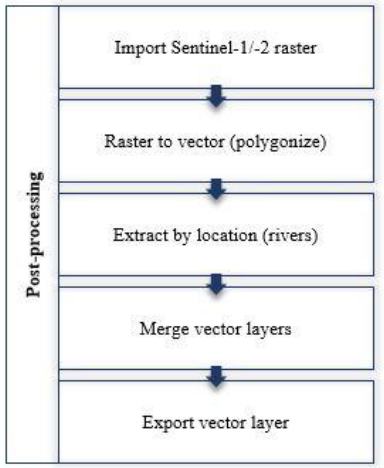
Figure 1. Sentinel-1 data processing scheme